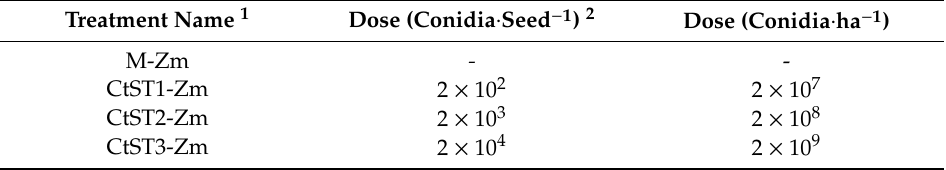
Table 1. Experimental design for the open-field maize